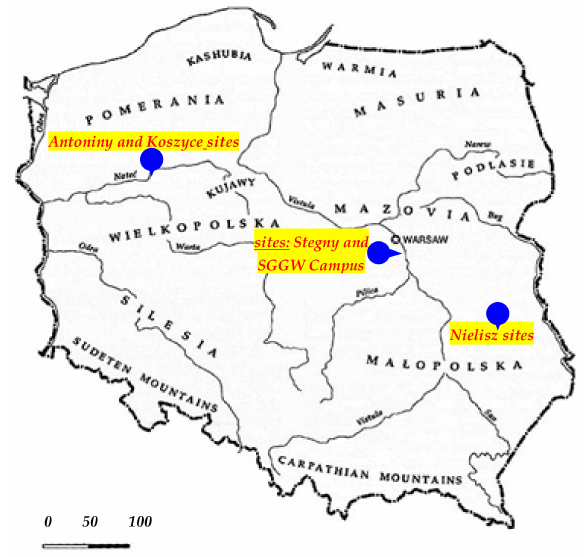
Figure 2. Location of test sites in Poland (all the test sites are located in